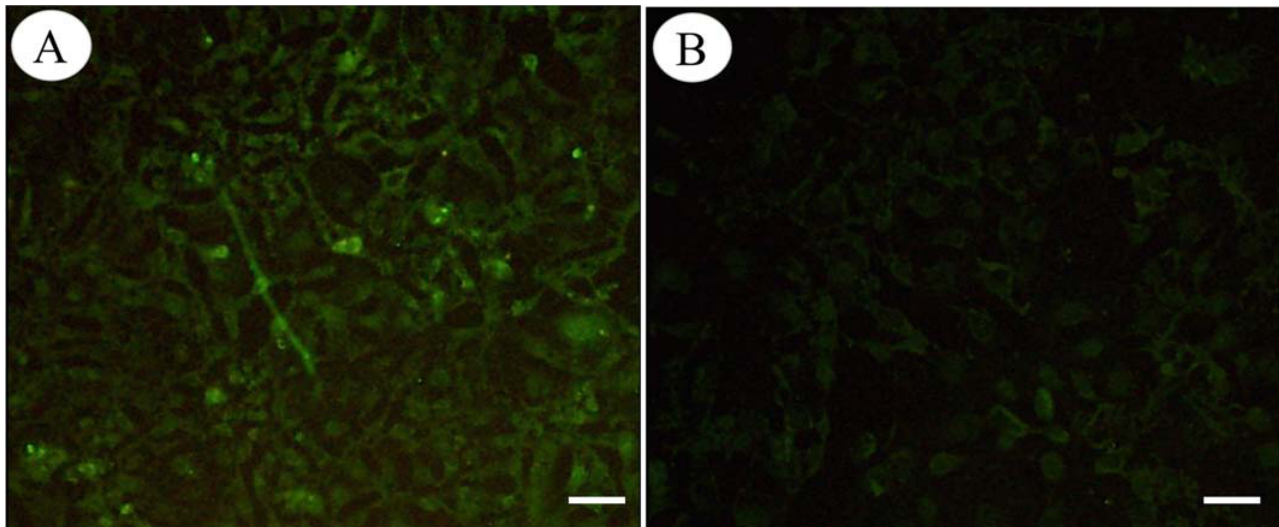
Figure 1. Immunofluorescence staining of HSP40 in HEK293 cells. HEK293 cells were transfected with pVAX1-HSP40 or pVAX1. At 72 h after transfection, the cells were fixed, permeabilized, and incubated with anti- T. gondii primary antibody. The cells were then incubated with fluorescein-conjugated secondary antibody and observed under a fluorescence microscope. The experiment was repeated three times, yielding similar results. The cells transfected with pVAX1-HSP40 showed the immunofluorescence of HSP40 proteins in the cytoplasm (A), whereas the cells transfected with the empty pVAX1 plasmid displayed little cellular immunofluorescence (B). Scale bar: 10 l